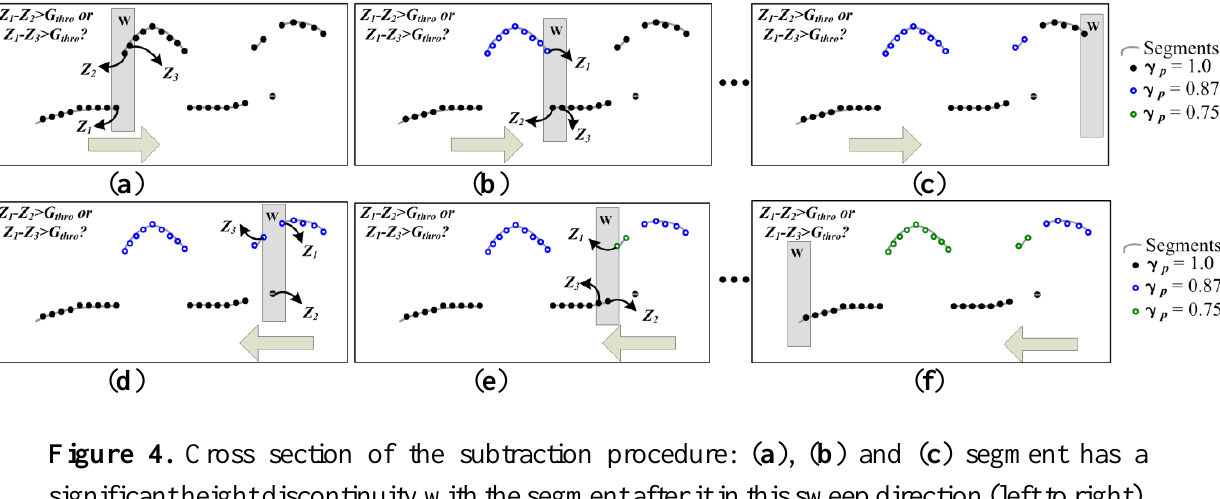
Figure 4. Cross section of the subtraction procedure: ( a ), ( b ) and ( c ) segment has a significant height discontinuity with the segment after it in this sweep direction (left to right), the ground saliencies of all grid cells in this segment subtract a constant value (0.125) in this simulated example; ( d ), ( e ) and ( f ) show the similar operation from right to left. Each grid cell has a unique ground saliency calculated according to the height differences between grid cell points. The ground saliency has nothing to do with the possible labels. Figure 5 exhibits an example of ground saliency results. Both the building and vegetation cells are highlighted, and they have relatively small ground saliencies (Figure 5b). The calculation of ground saliency does not mean a precise classification of each grid cell. Instead, it is used to adaptively balance the energy terms in (2) other than using a constant coefficient. Given that the building and vegetation cells have relatively small (even 0) ground saliencies, the regularization term (in Equation (2)) of these places is dominant. This case can prevent the classification surface from being attracted to large low buildings and